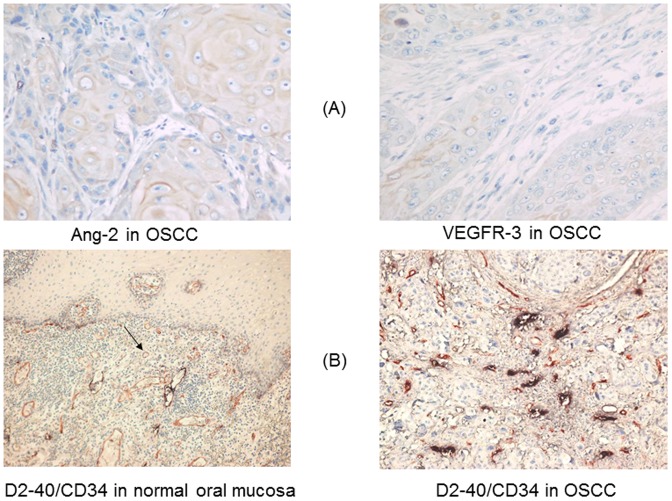
Immunohistochemical expression of Ang-2 and VEGFR-3 in OSCC (streptavidin/avidin-biotin complex ×400) (A) and CD34 (scarlet; blood vessels) and D2-40 (purple-black; lymphatic vessels) in OSCC and normal oral mucosa (streptavidin/avidin-biotin comple double-labeling ×400) (B).